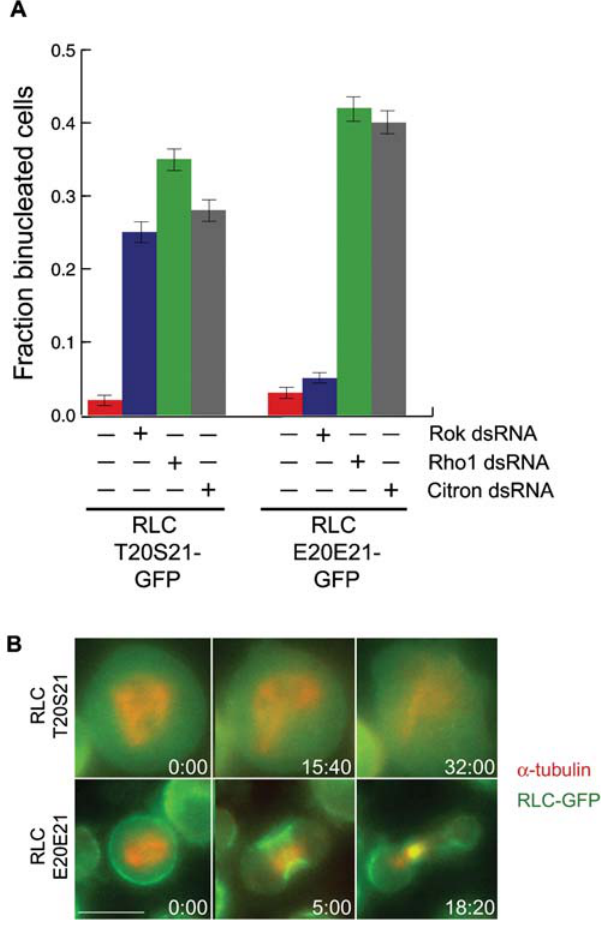
Figure 3. The only essential role of Rok during cytokinesis is to maintain phosphorylation of myosin II RLC. (A) S2 cells expressing RLCT20S21-GFP or RLCE20E21-GFP were treated with dsRNAs for 5 days to deplete Rho1, Rok, or Citron and then fixed and stained with DAPI. The fraction of binucleated cells (mean, 6 SE for approximately 200 cells) was determined by fluorescence microscopy. Expression of RLCE20E21-GFP rescues depletion of Rok, but not Rho1 or Citron. (B) Expression of phospho-mimic RLC rescues Rok depletion. S2 cells expressing RLC-GFP chimeras (green) and RFP- a -tubulin (red) were depleted of the Rok by RNAi treatment for five days, and timelapse fluorescence microscopy was used to film cells as they attempted to divide. RLCT20S21-GFP (Row 1) was not recruited to the equatorial cortex at anaphase and the cells did not contract. RLCE20E21-GFP (Row 2) was recruited to the equatorial cortex during mitosis and the cells contracted. The scale bar=5 m m.